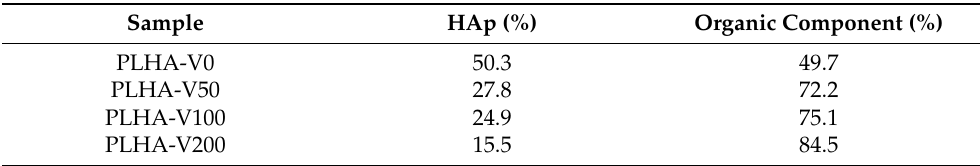
Table 2. Organic/inorganic percentage of PLHA-V x